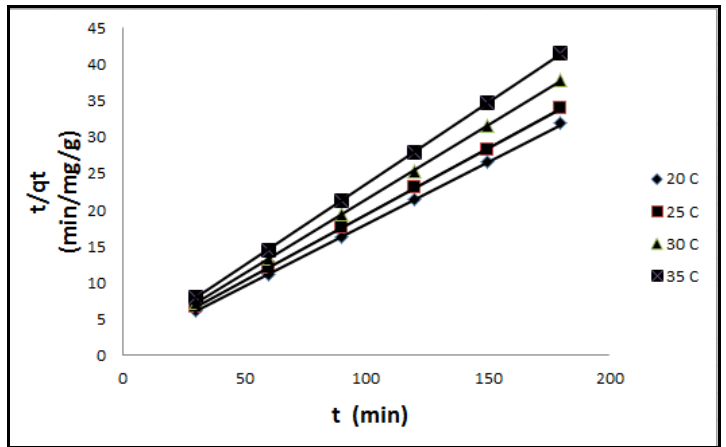
Fig. 10. second order kinatic model for methylene blue at tempreture range (20−35) °C.